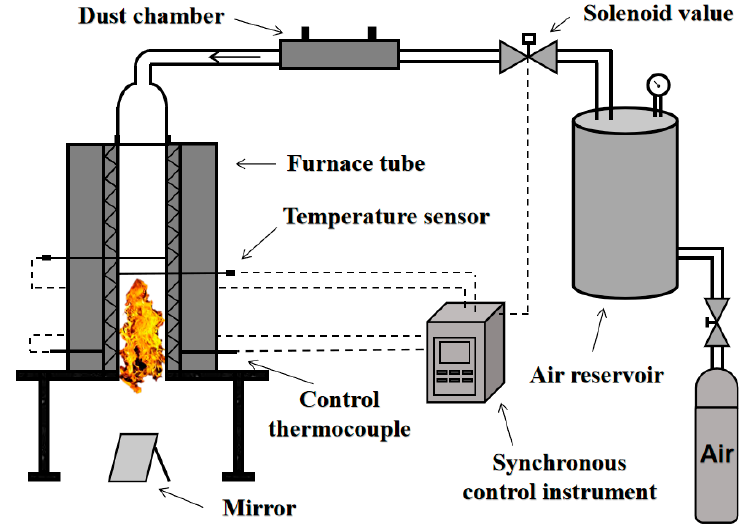
Figure 1. Experimental apparatus for the minimum ignition temperature (MIT) test.